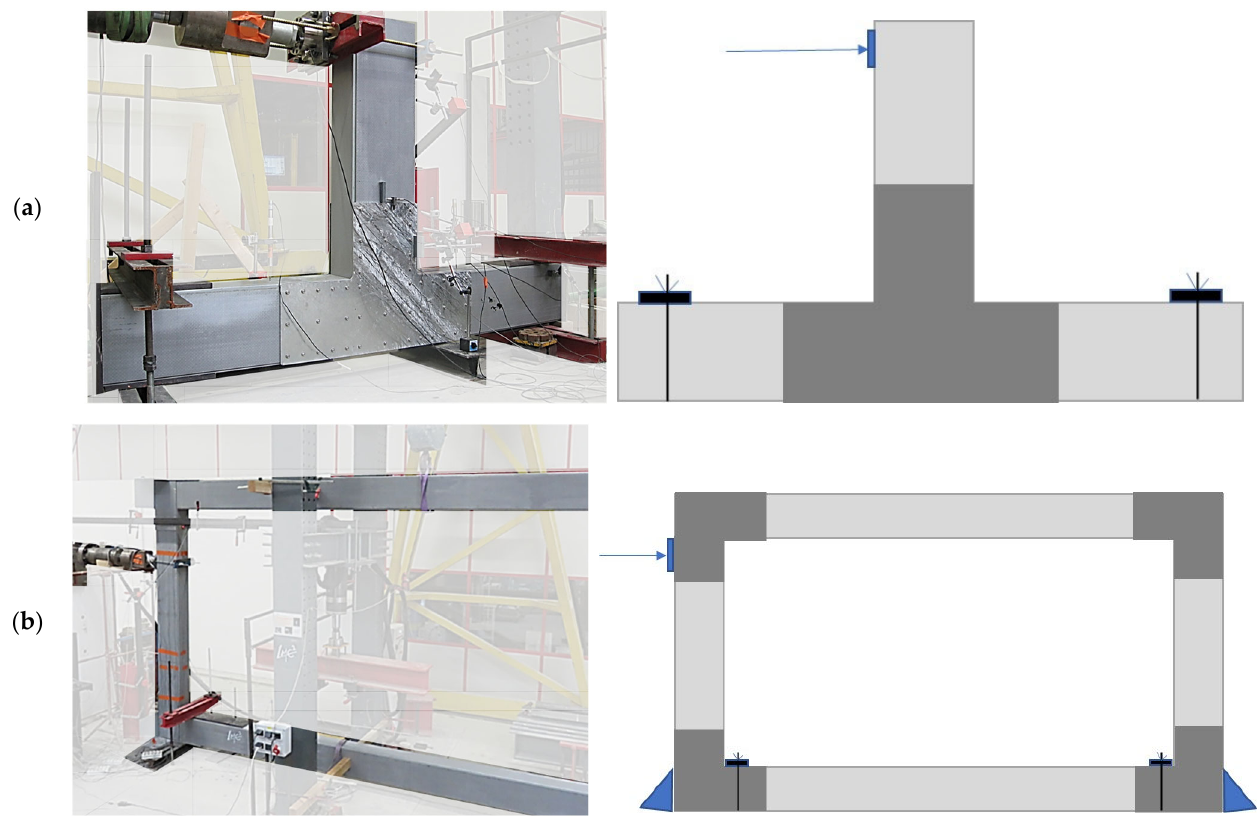
Figure 4. View of the specimen tested: ( a ) beam ‐ to ‐ column; ( b ) portal